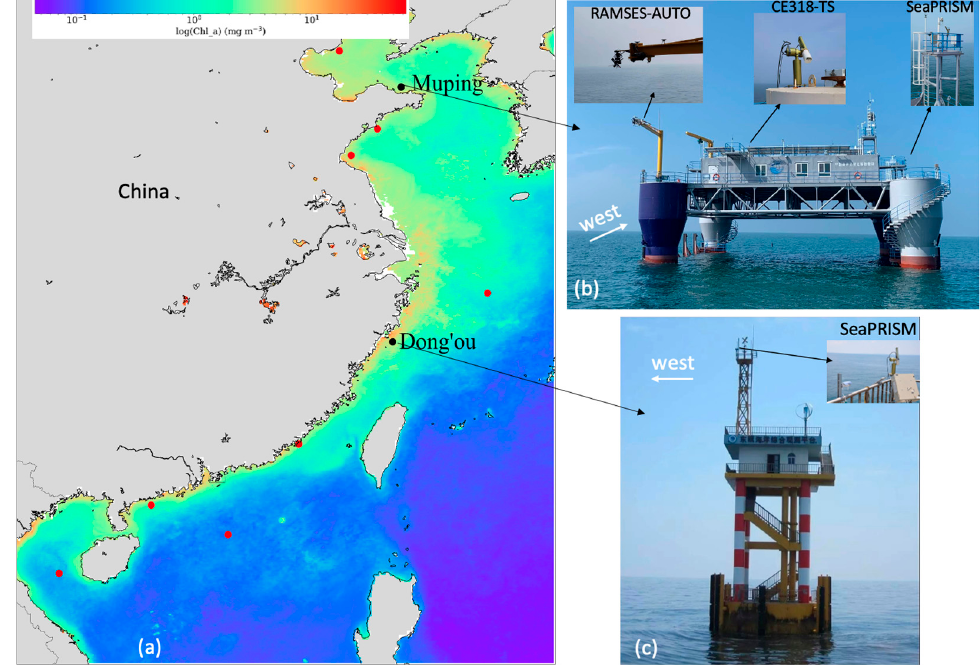
Figure 2. ( a ) Location of ten AERONET-OC type sites along the China coast. The black dots are the Muping and Dong’ou sites and the red dots are the eight sites under construction. The background is the annual mean chlorophyll concentration derived from MODIS/Aqua in 2021. ( b , c ) are photographs of platforms at the Muping and Dong’ou sites. The inserts are the instruments (SeaPRISM, CE318-TS, and RAMSES-AUTO) deployed on each platform.